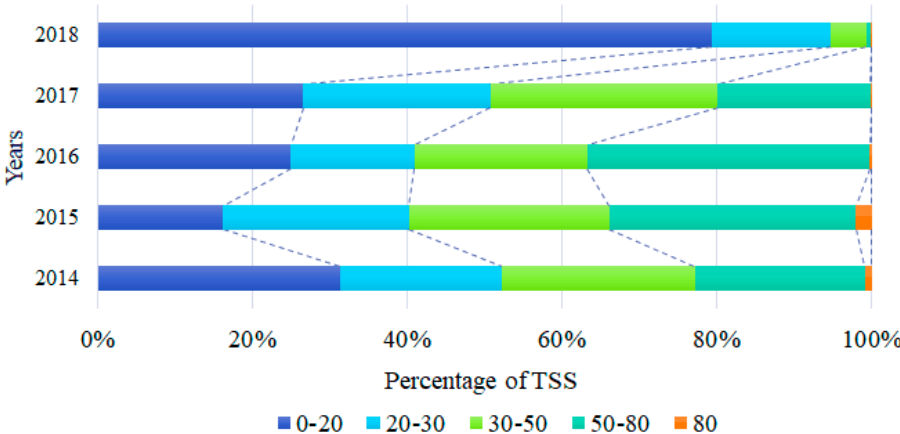
Figure 6. Percent distribution of annual average concentrations of TSS in Shijiao Town from 2014 to 2018, including levels with thresholds of 20, 30, 50 and 80 mg/L.